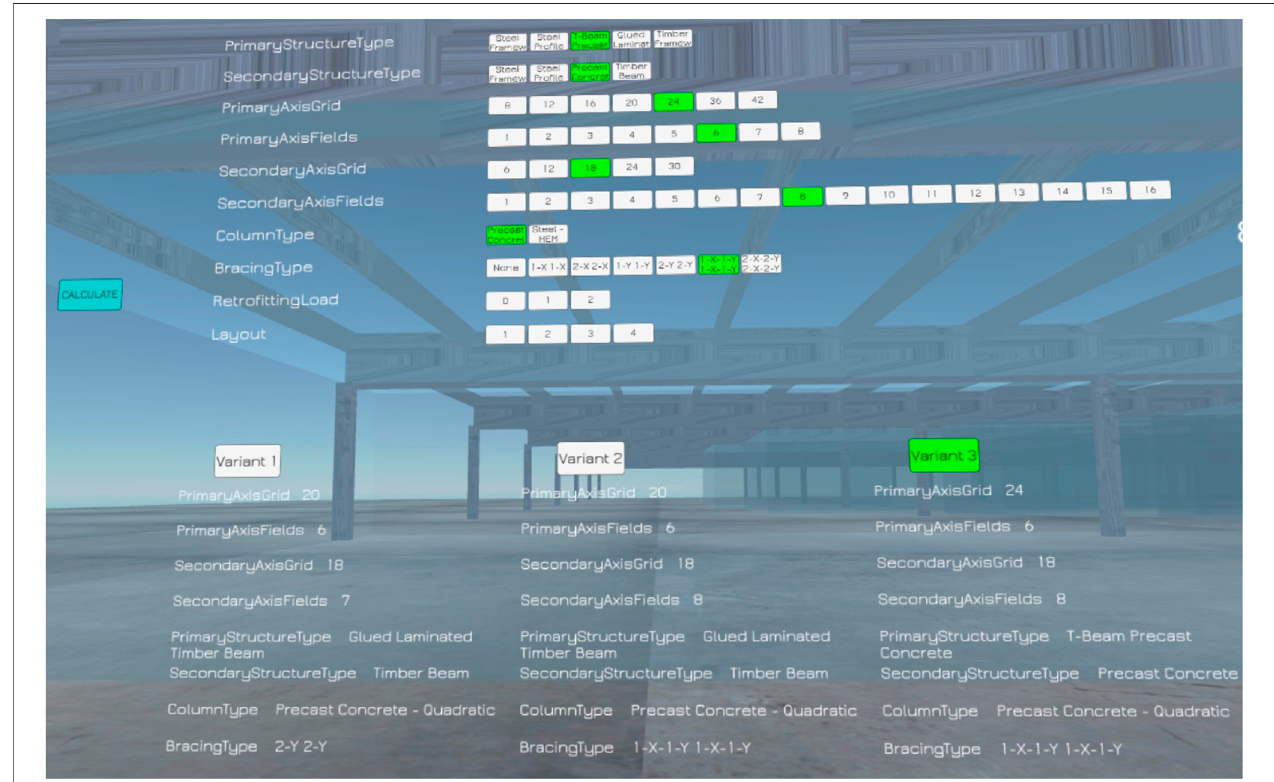
FIGURE 6 | In-game menu allowing users to choose parameters of the structural system and the preferred production layout (screenshot of a user ’ s VR view). Variant 1, Variant 2, and Variant 3 correspond to optimal parameter sets found during multi-objective optimization. Parameters displayed in green belong to the current